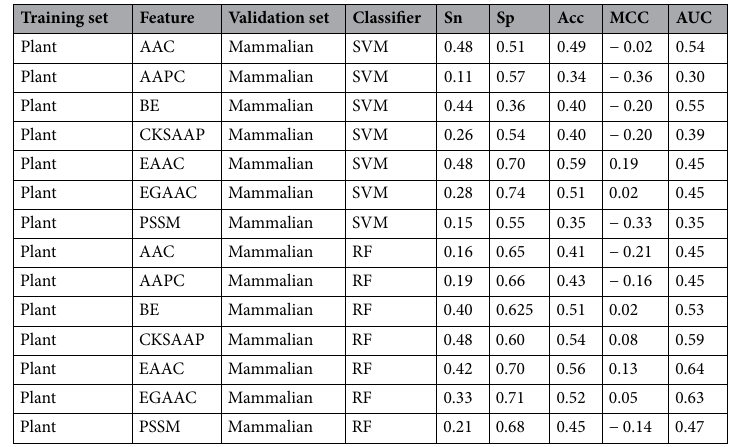
Table 6. Performance of cross-species evaluation. In this evaluation, the plant dataset were treated as the training set and mammalian dataset as the testing